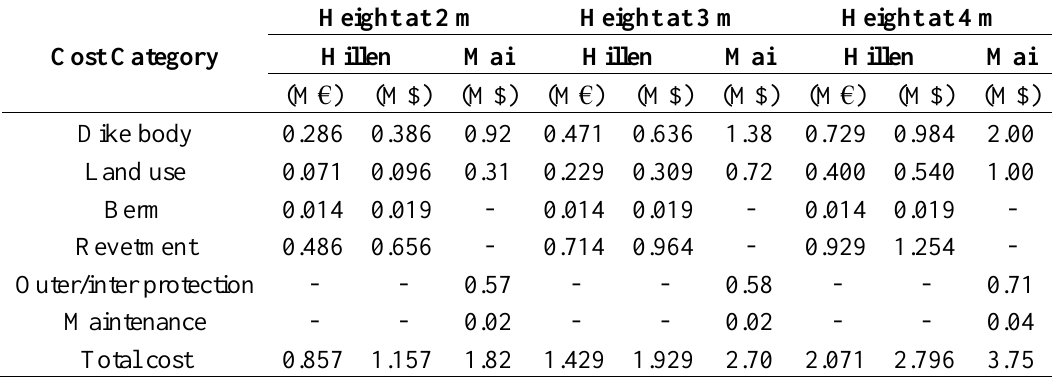
Table A6. Decomposition of dike construction and maintenance costs (per km) in rural Vietnam. Source: Hillen et al. [10].